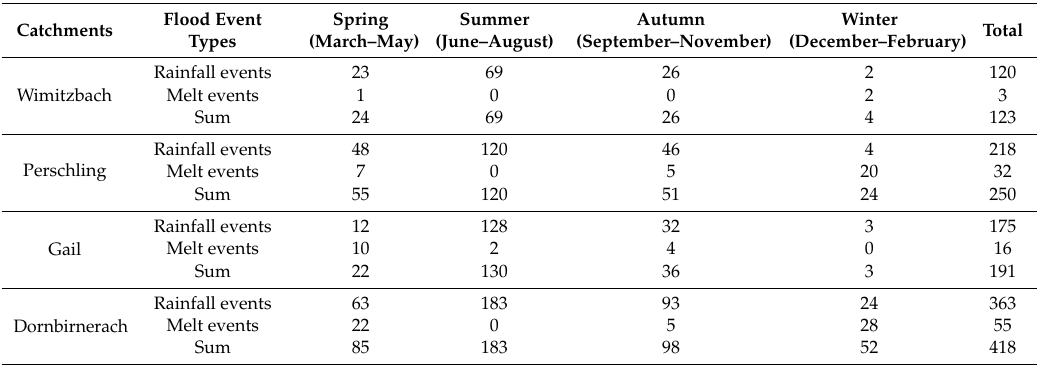
The seasonal frequency of identified runo ff events in Wimitzbach, Perschling, Gail, and Dornbirnerach catchments in the period 2002–2013.